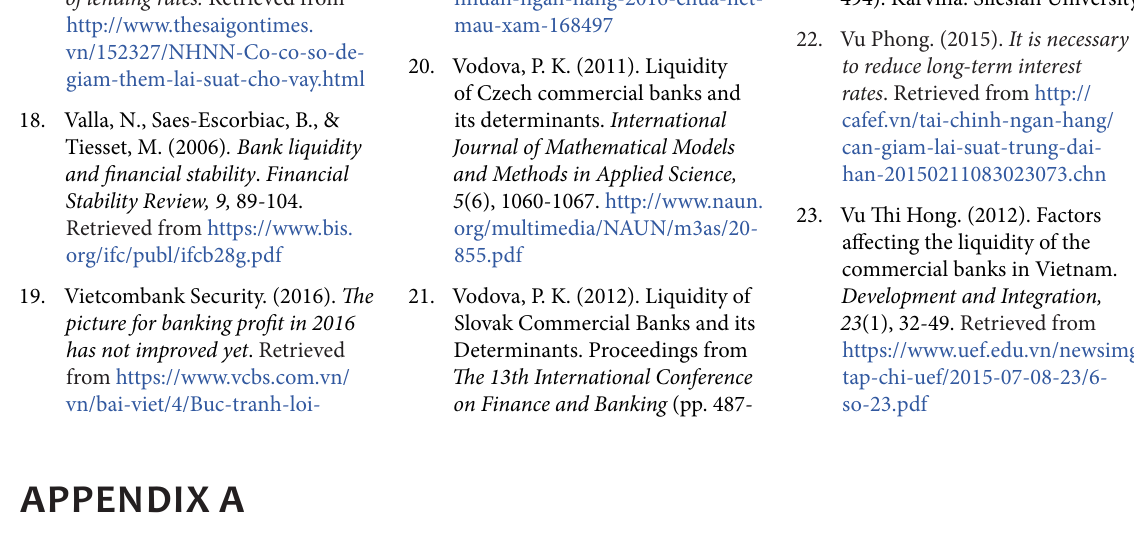
Table A1. The internal variables in the study No. Acronym The names of